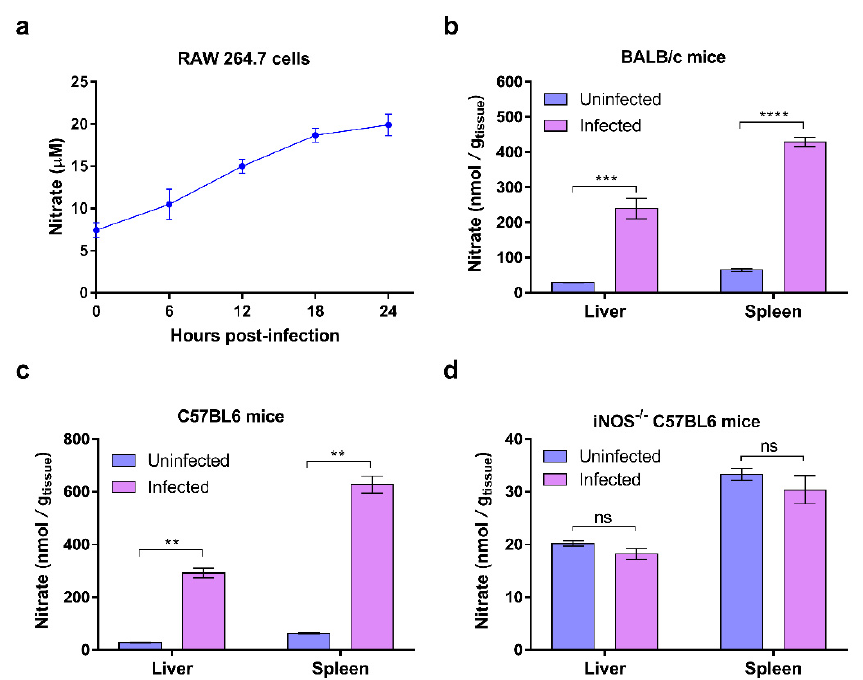
Figure 1. Nitrate levels are increased during systemic infection by S. Typhimurium. ( a ) Nitrate levels in RAW264.7 cells after 0, 6, 12, 18, and 24 h of infection with S. Typhimurium WT strain. ( b , c ) Nitrate levels in the livers and spleens of BALB/c mice ( b ) and C57BL/6 mice ( c ) that were infected or mock-infected with S. Typhimurium WT strain after 5 days post-infection. ( d ) Nitrate levels in the livers and spleens of iNOS-deficient C57BL/6 mice that were infected or mock-infected with S. Typhimurium WT strain after 5 days post-infection. ( a – d ) Data were generated from three independent experiments and are presented as the mean ± SD. p -values were determined using unpaired Student’s t -test (** p < 0.01; *** p < 0.001; **** p < 0.0001; ns, not significant).